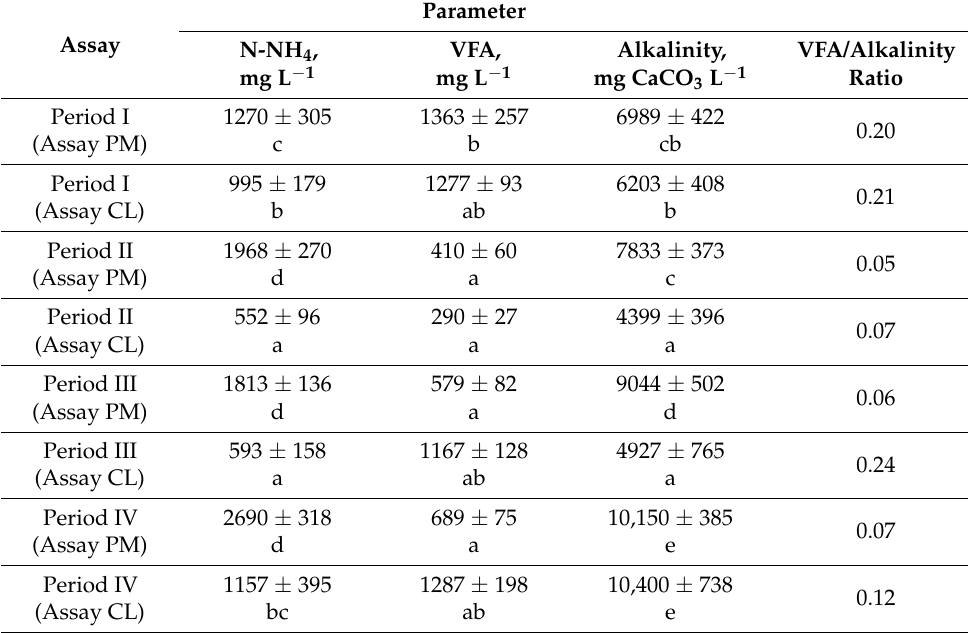
Table 3. ANOVA analysis for p and L